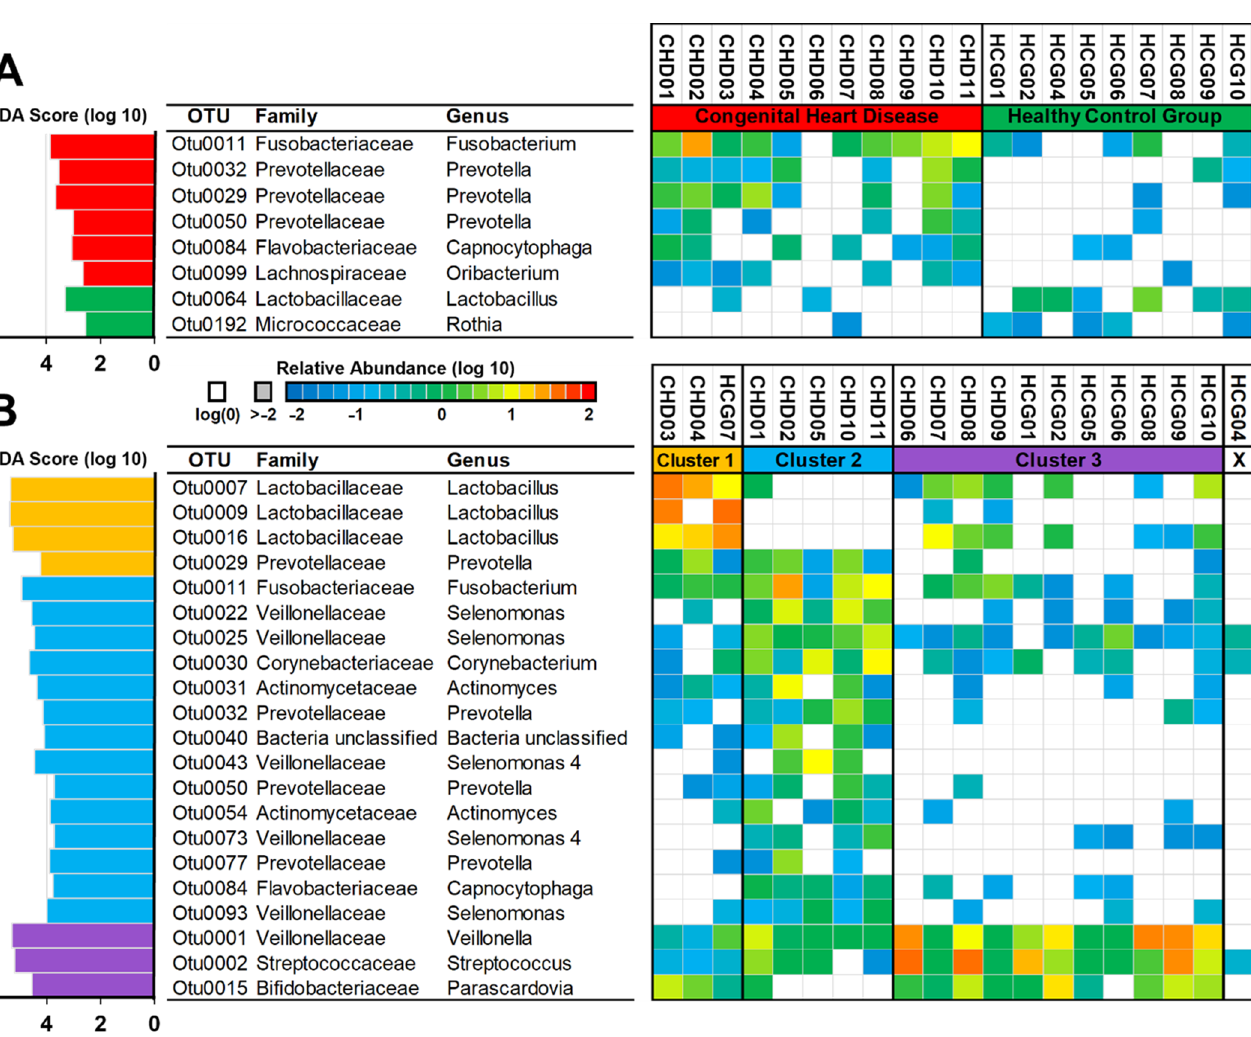
Figure 5. LEfSe for CHD vs. HCG ( A ) and the three distinct clusters observed in the PCoA of Bray–Curtis ( B ). LDA score for significantly different OTUs between the three clusters (left), taxonomic classification (center), and heatmap showing the log-10 transformed relative abundance for each OTU (right).